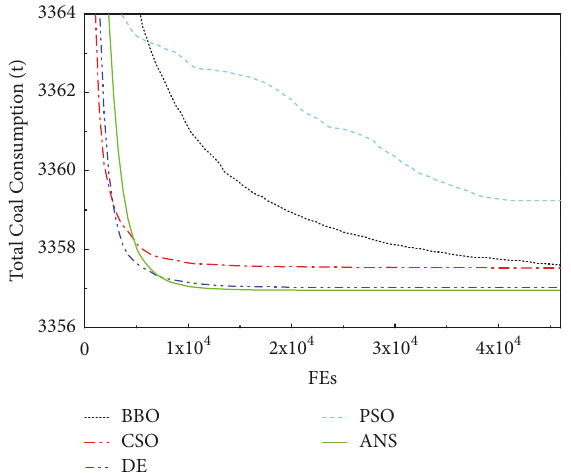
Figure 8: Convergence curves for the practical provincial power grid of